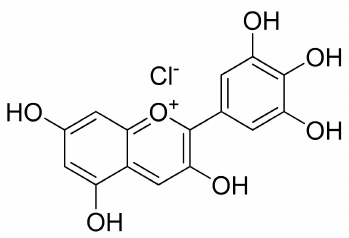
Figure 12. Chemical structure of